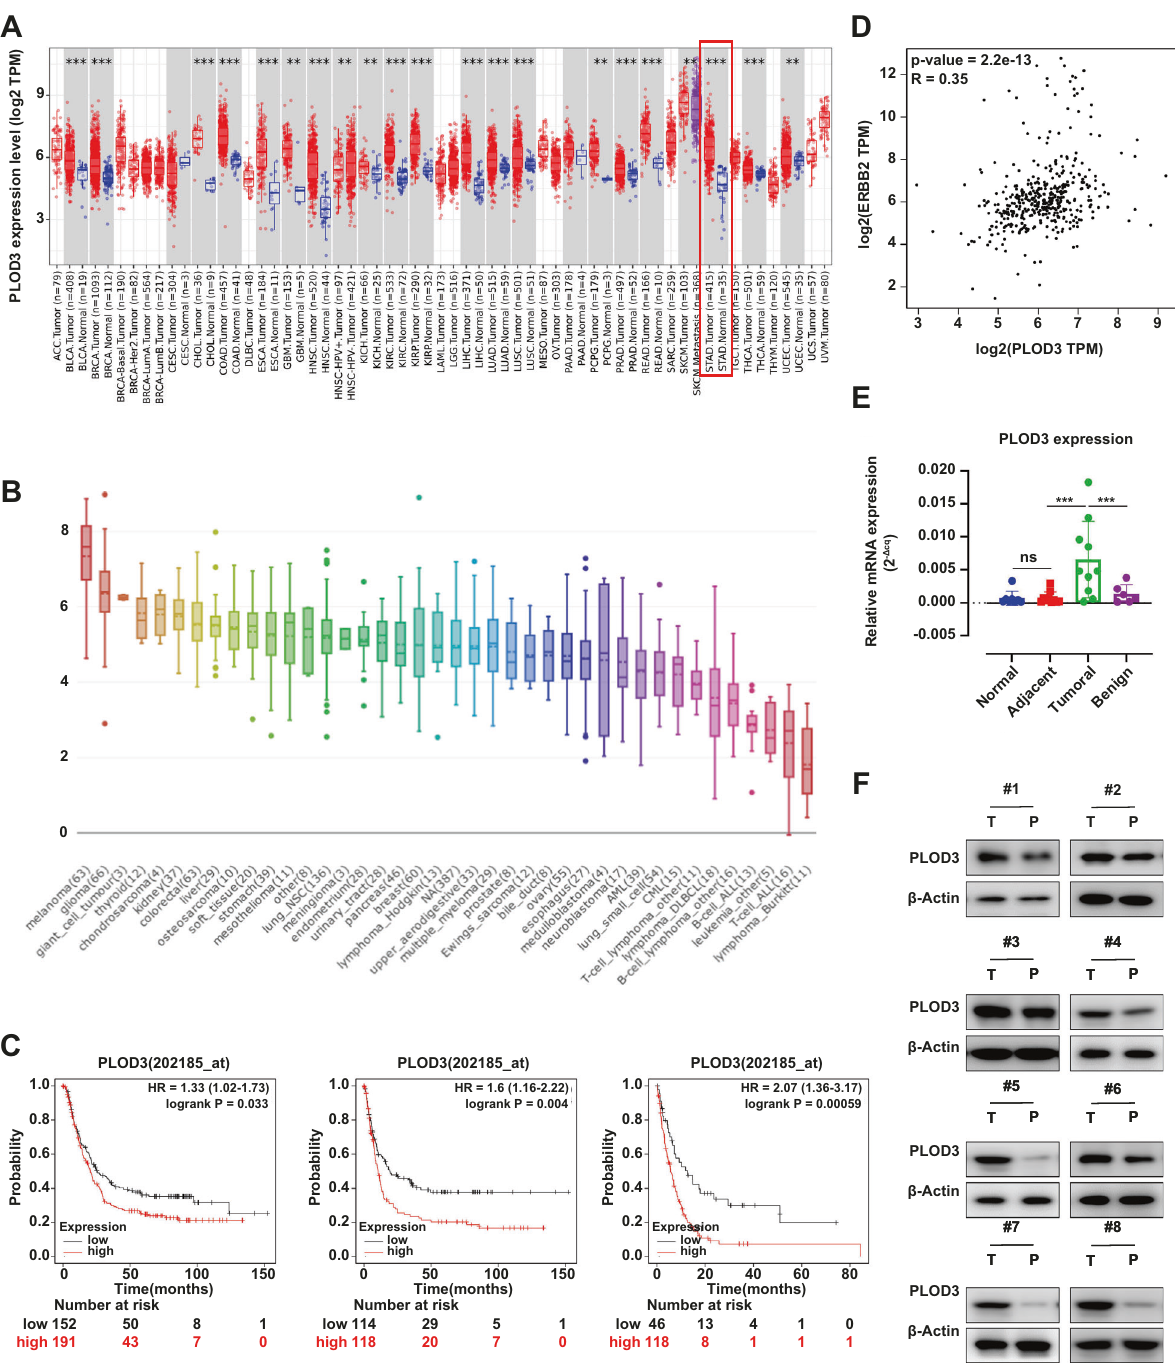
Fig. 4 PLOD3 was essential for GC progression. A Comparisons of PLOD3 mRNA expression levels between normal and cancerous tissues according to TCGA database. B PLOD3 displayed high expression pattern in GC cell lines according to CCLE database. C Kaplan-Meier analysis of overall survival, fi rst progression and postprogression survival of patients according to PLOD3 expression status (high or low). D The association between PLOD3 expression and HER-2 expression according to STAD dataset of TCGA database. E , F PLOD3 was highly expressed in GC patients (T) compared to paired normal tissues (P) by conducting RT-PCR and immune-blotting immune-blotting assays (Fig. 7C, D). Importantly, silencing Survivin FoxO3/Survivin axis. To validate this, we explored the expression expression in Trastuzumab resistant GC cells could induce GC cells of Survivin after PLOD3 knockdown. Our results showed that sensitized to Trastuzumab according to MTT assays (Fig. 7E). On PLOD3 knockdown by two different shRNAs led to decreased the contrary, forced expression of Survivin in PLOD3 knockdown Sruvivin expression on both mRNA and protein levels in multiple GC cells could restore the Trastuzumab-resistance potentials GC Trastuzumab resistant cell lines (Fig. 7A, B). Meanwhile, (Fig. 7F). Taken together, above results indicated that PLOD3 silencing FoxO3 expression in PLOD3 knockdown cells could exerted its drug-resistance promoting capacity via inducing FoxO3 restore Survivin expression, illustrated both by RT-PCR and